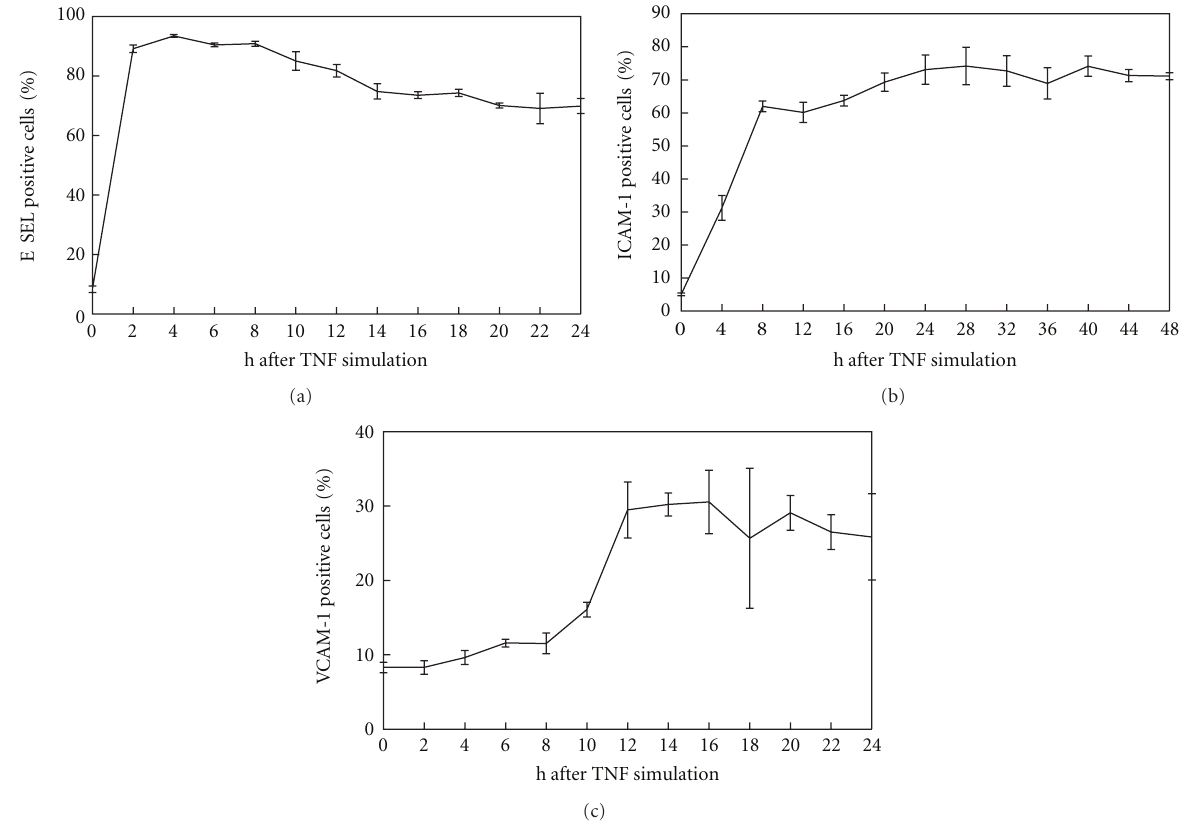
Figure 1: Increase of the adhesion protein receptor expressions of ESELE, ICAM-1, and VCAM-1 during the first 24 hours after TNF- α stimulation. The y -axis represents the percentage of the respective receptor expression, and the x -axis represents the time after TNF- α stimulation in